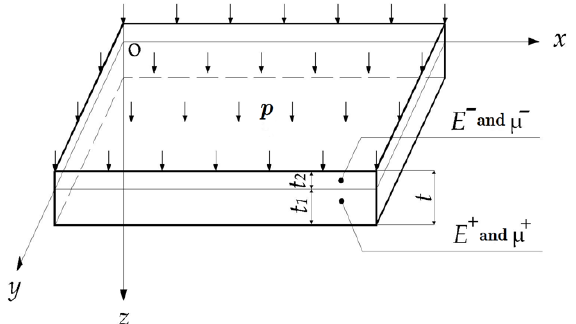
Figure 3. Bending analysis of a bimodular rectangular thin plate.